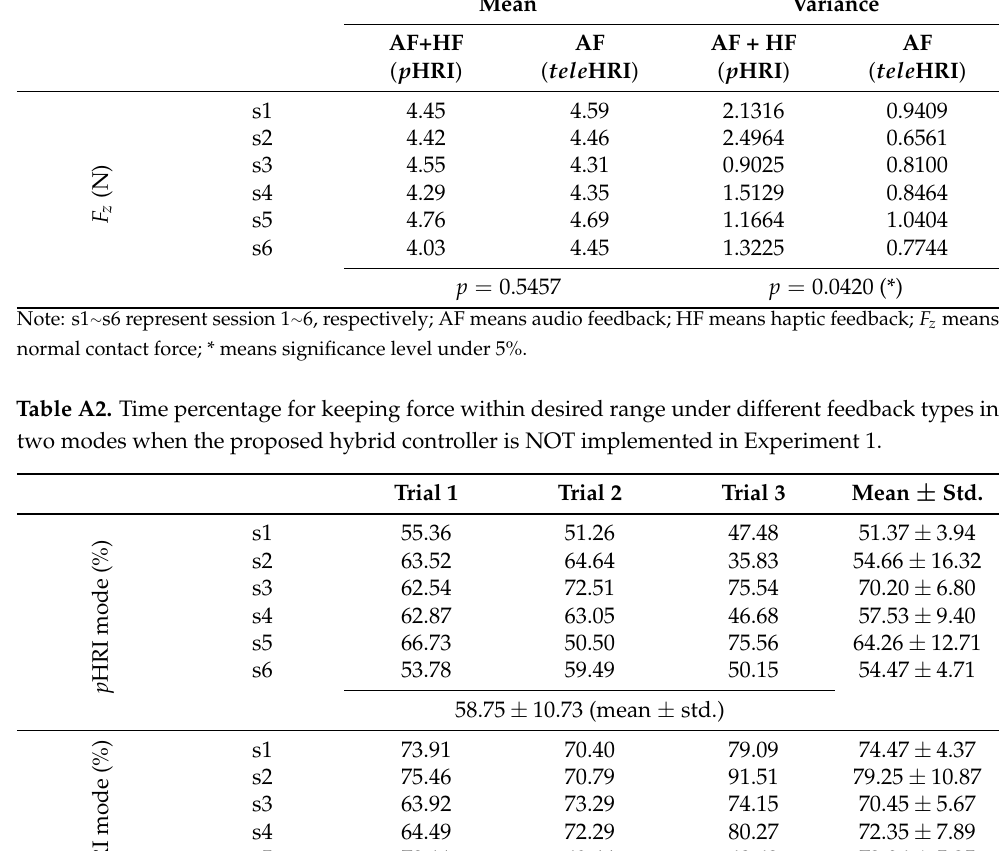
Table A1. Comparing task performance under different feedback types in two modes when the proposed hybrid controller is NOT implemented in Experiment 1.